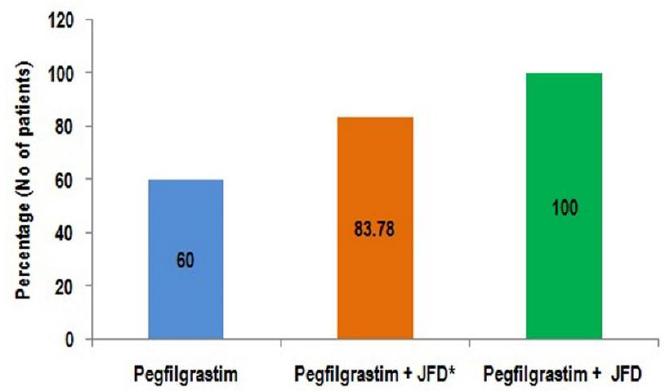
Figure 1. Effect of JFD in the prevention of Leukopenia; * Including six patients who could not take JFD in all cycles .